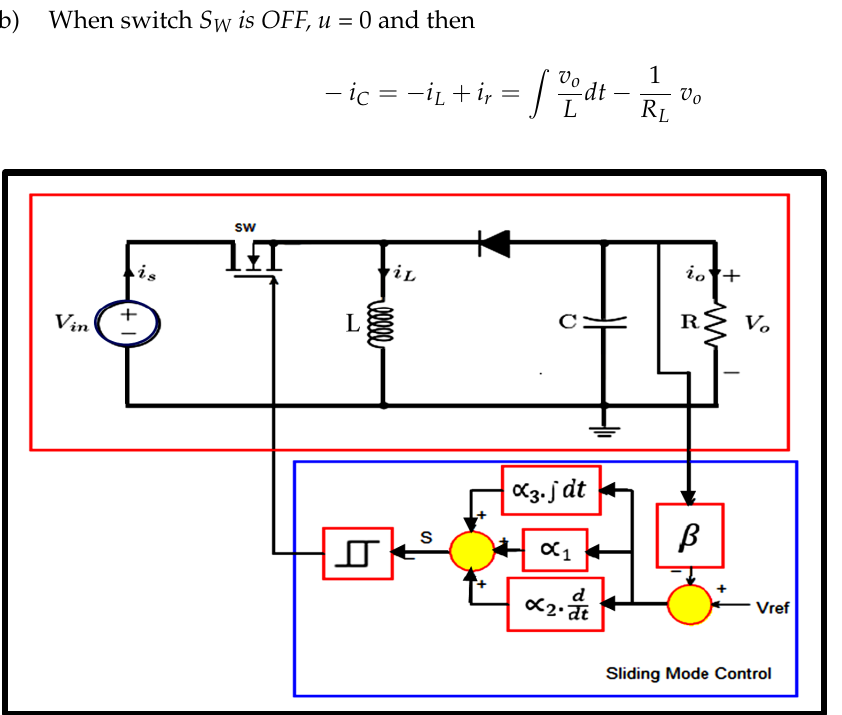
Figure 5. A schematic diagram of a PID-based sliding mode voltage-controlled BB